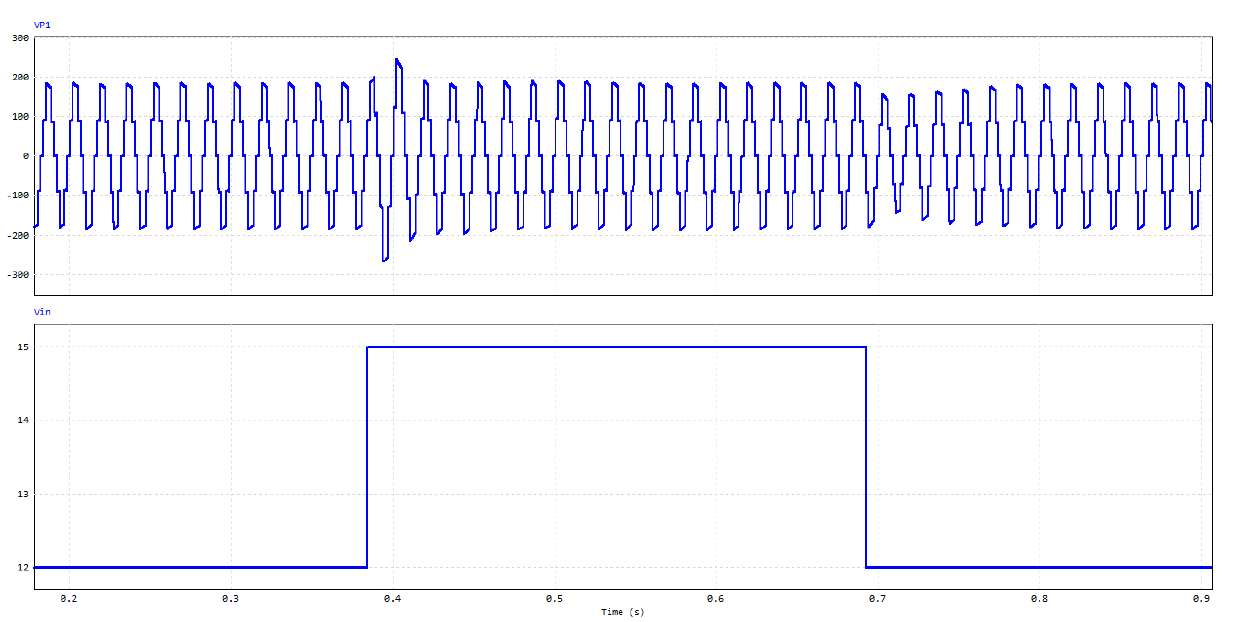
19 of 22 Figure 26. Controller diagram.